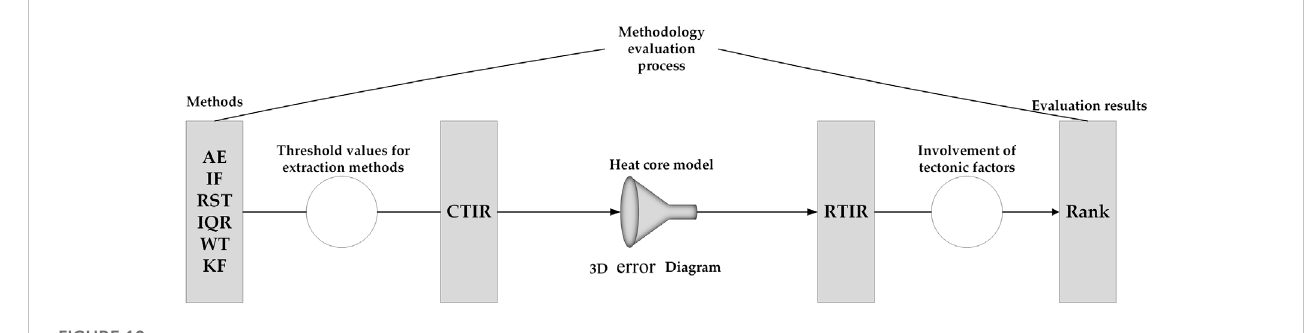
FIGURE 10 TIR anomaly method evaluation fl ow